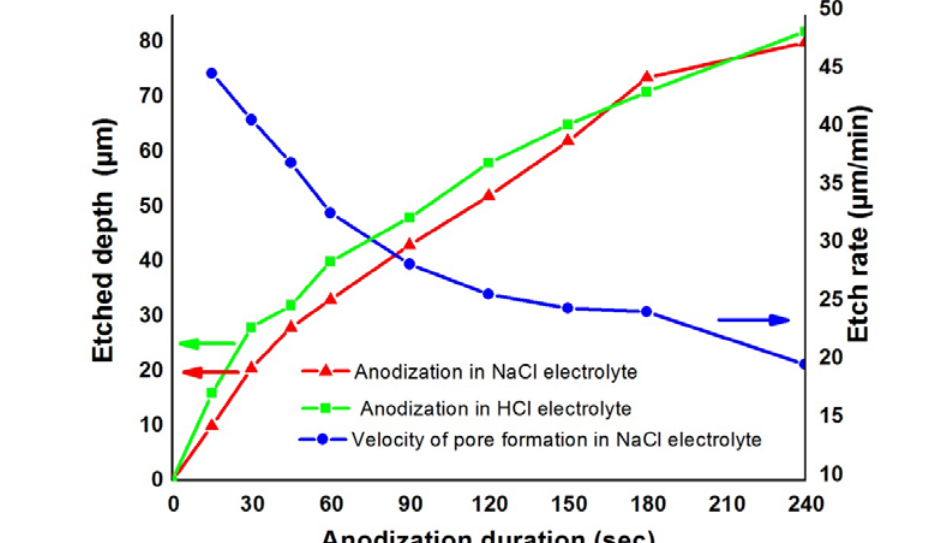
Figure 5. Evolution of thickness of porous layer and etch rate of anodized InP crystal in NaCl an d HCl electrolyte.